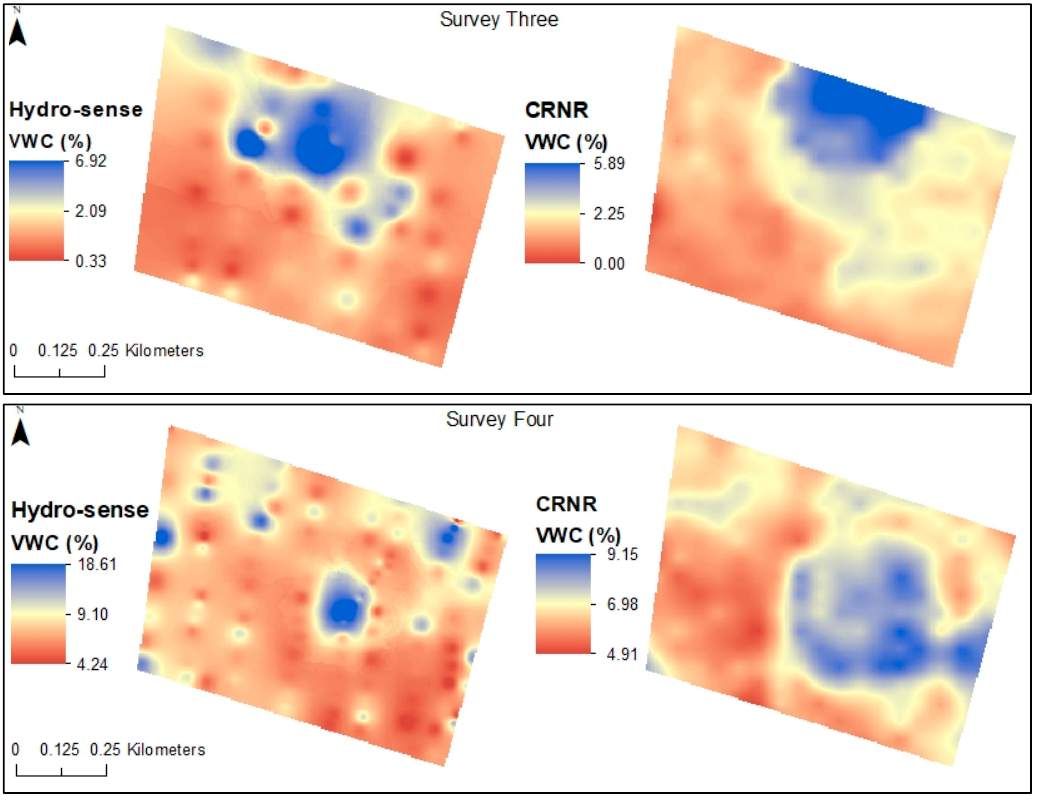
Figure 8. Pine hydro-sense and CRNR soil water maps.